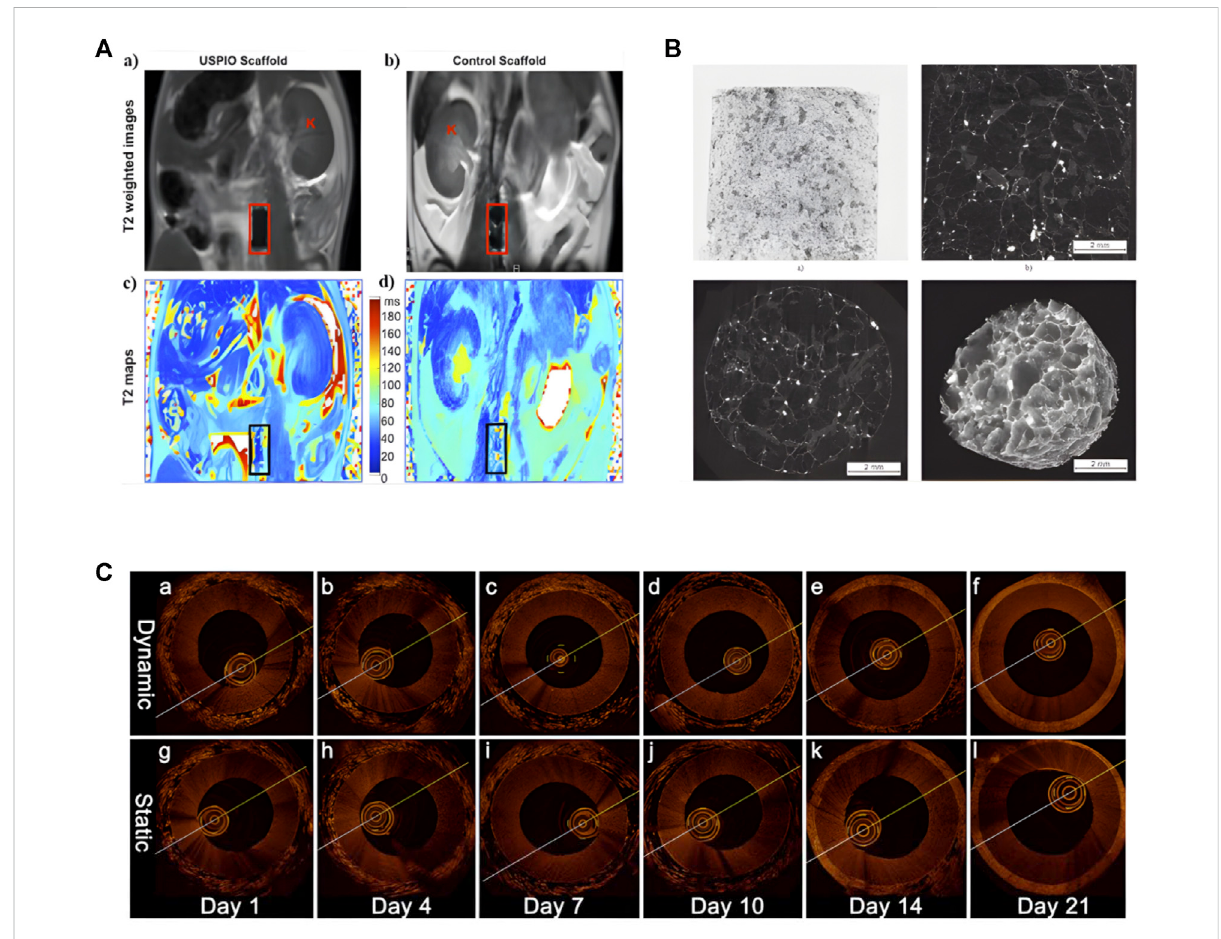
FIGURE 5 Application of Different Imaging Methods in Tissue Engineering. (A) Noninvasive MRI images of labeled and unlabeled stent-grafts in mice, a, b) RARE T2-weighted images of labeled (a) and unlabeled. (b) seed scaffolds after implantation. Boxes represents the location of the graft and K represents kidneys. c, d) Corresponding T2 maps of a, b) (adapted and modi fi ed from Harrington et al., 2011). (B) micro-CT scanning of collagen- based scaffold (adapted and modi fi ed from Barto š et al., 2018). (C) OCT imaging contrasting the effects of pulsatile stimulation on tissue- engineeredvasculargraftsculture,(a – f)areimageswitharterialstimulation,(g – l)areimageswithoutarterialstimulation(adaptedandmodi fi edfrom Chen et al.,